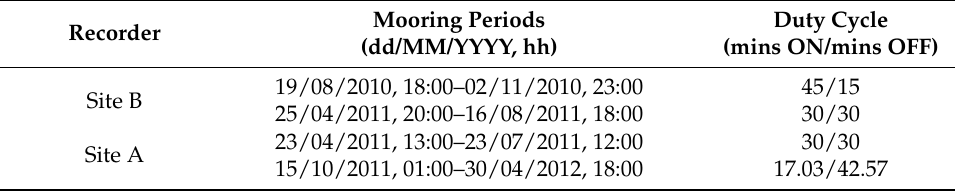
Table 1. Summary of the characteristics of recordings performed in each site for each year. Mooring Periods Duty Recorder